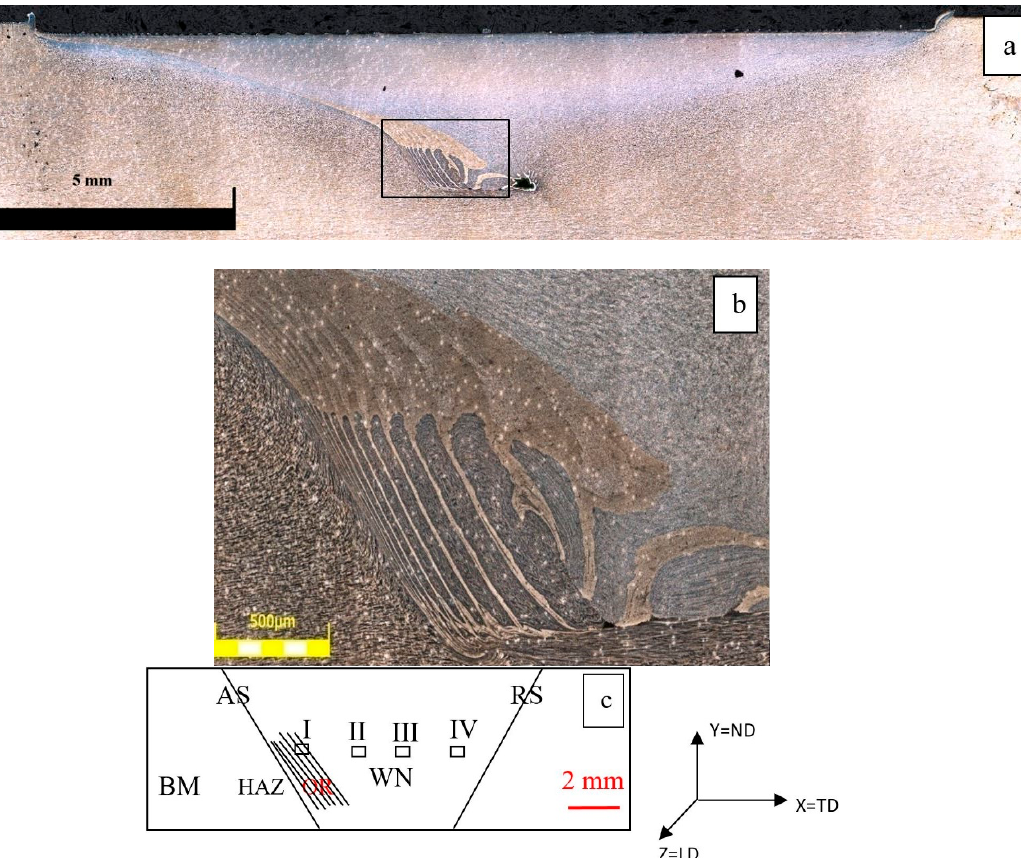
Figure 3. ( a ) Cross-sectional macrostructure of Sample T4; ( b ) optical micrograph of the OR zone; ( c ) schematic representation showing different locations of microstructure examinations. BM: base metal, AS: advancing side, RS: retreating side, WN: weld nugget, HAZ: heat affected zone, ND: normal direction, TD: transverse direction, LD: longitudinal direction.